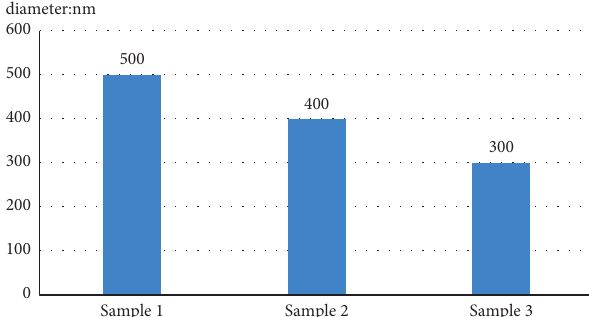
Figure 6: Average size of products obtained from three samples by Au I